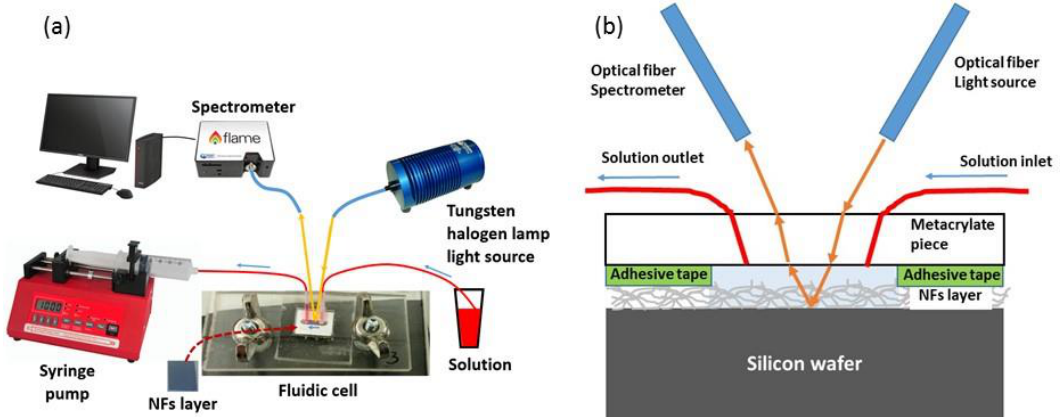
Figure 3. ( a ) Scheme of the opto-fluidic setup used to carry out the sensing experiments in real-time. ( b ) Sketch of the sensing region.